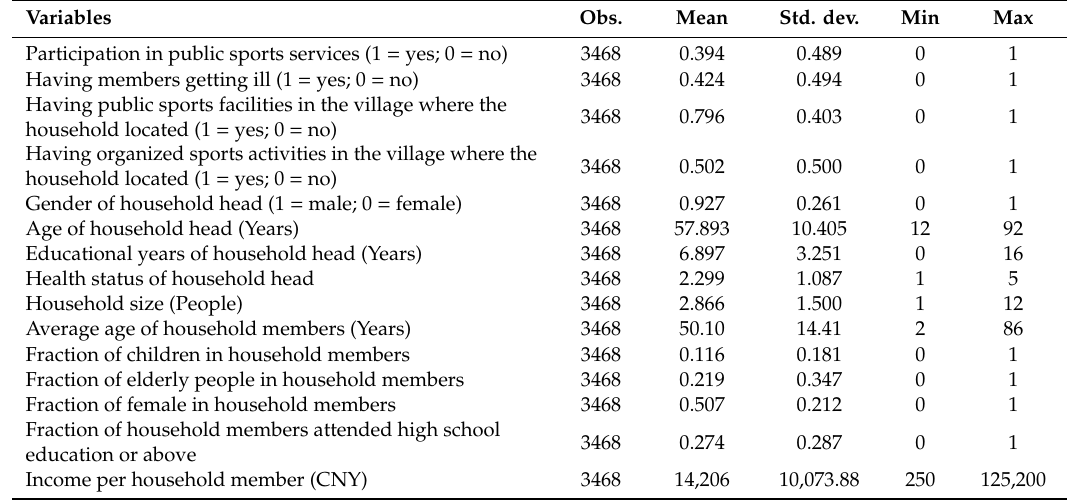
Table 3. Description of the variables used for model